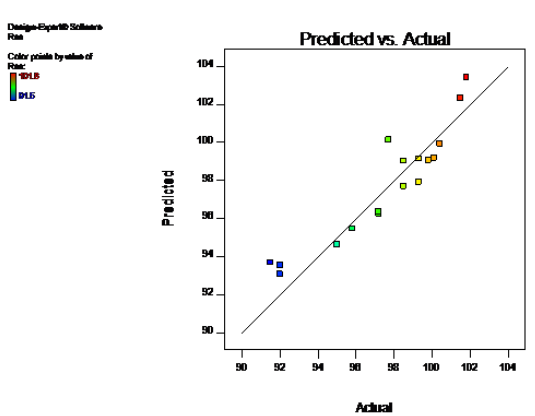
Figure 4. Comparison between actual andcalculated values of ON from quadratic model